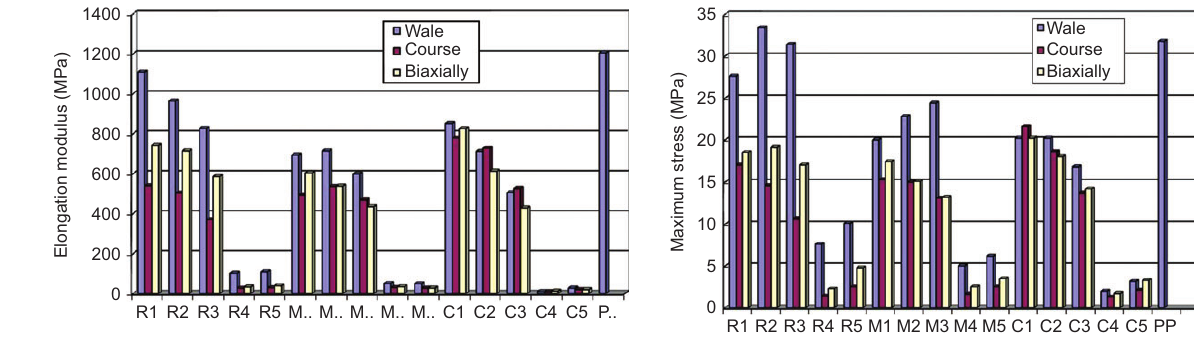
Figure 3 Results of composite ’ s elongation modulus.